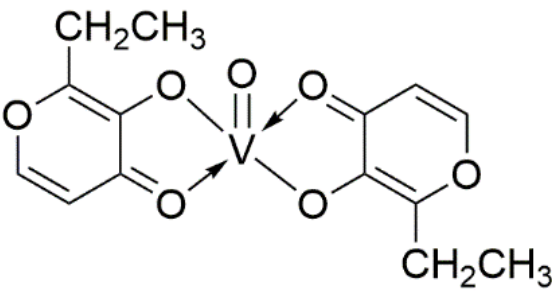
Figure 1. Molecular structure of Bis(2-ethyl-3-hydroxy-4-pyronato) oxovanadium (IV).